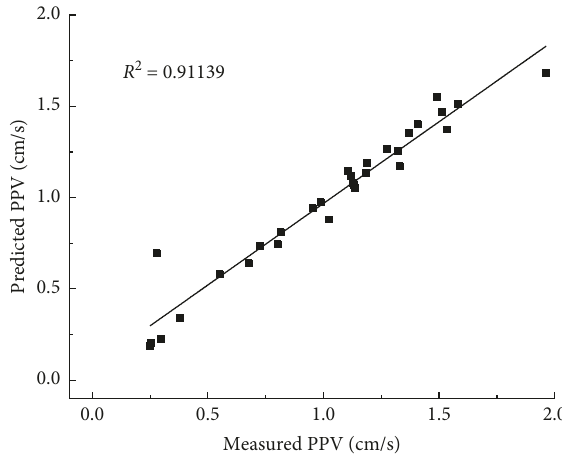
Figure 12: Measured PPVs against predicted PPVs fitted by Langefors–Kihlstrom.